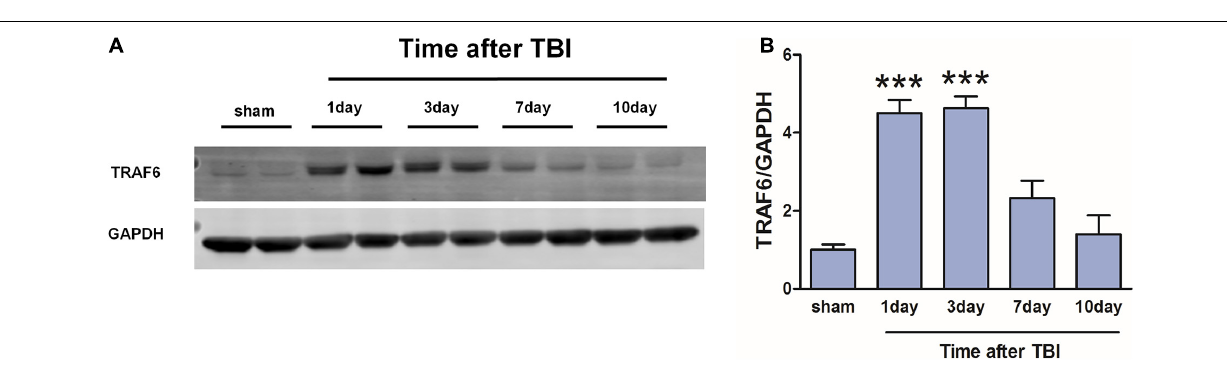
FIGURE 3 | Transiently increased cortical expression of TRAF6 following TBI. (A) Protein expression of TRAF6 was determined by Western blot analysis. GAPDH was used as an internal control. (B) The optical density of the bands was analyzed by ImageJ. The values are presented as the mean ± SEM. *** P < 0.001 vs. sham